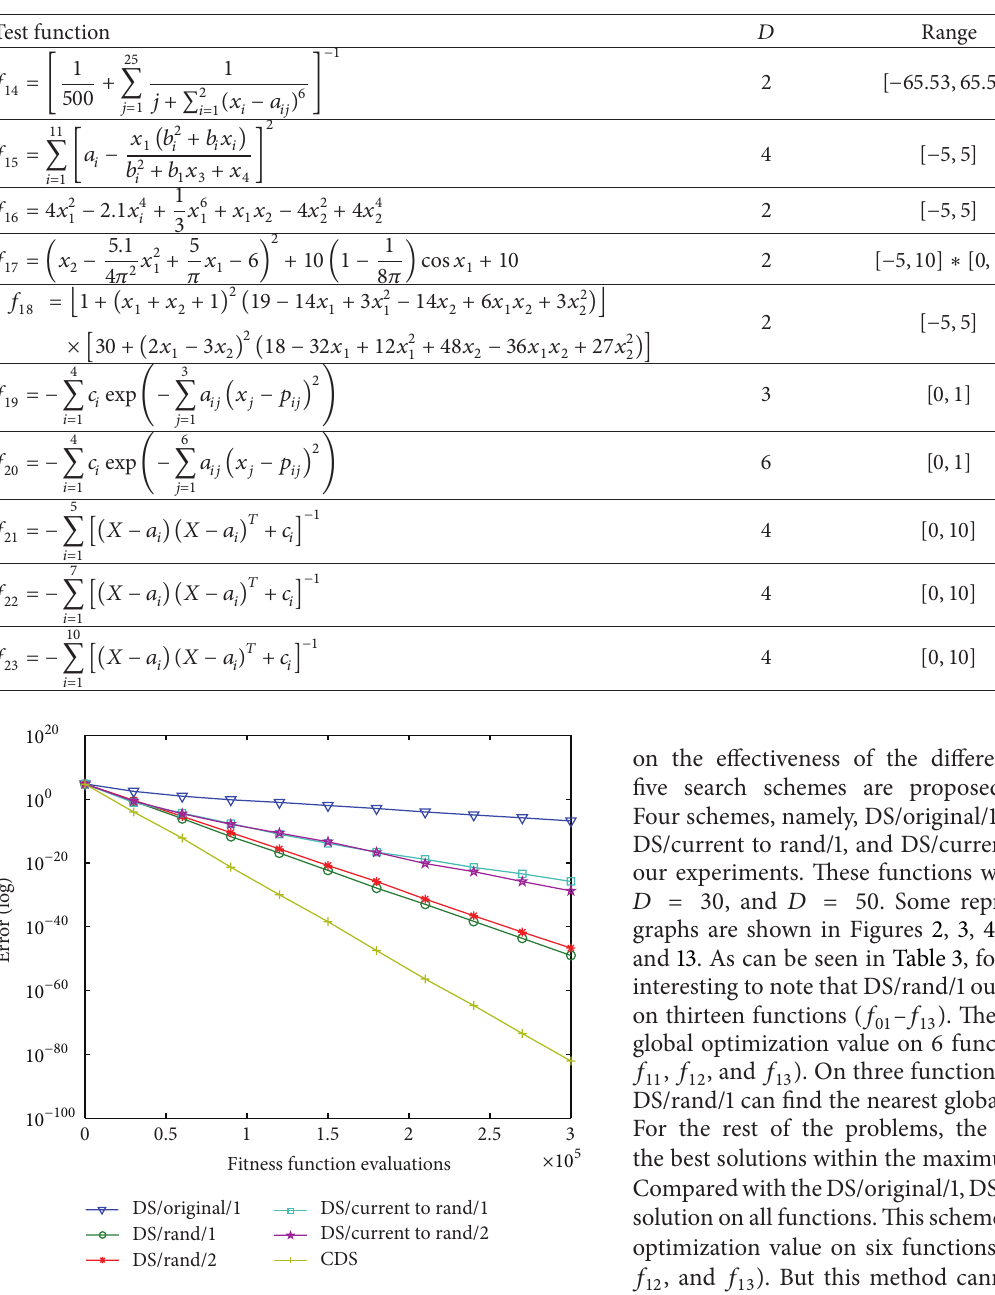
Figure 2: Comparison of performance of six algorithms for mini- mization of 𝑓 01 with dimension